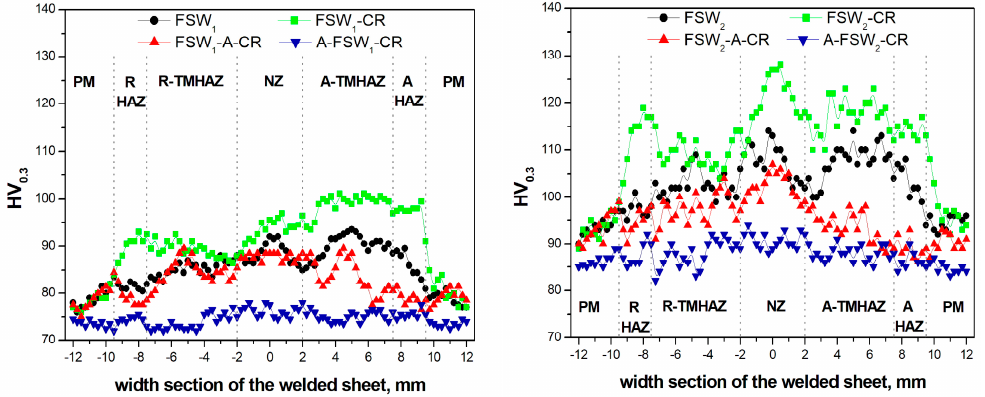
Figure 8. Microhardness profiles across the welded zone sections in the FSW, FSW-CR, and FSW-A-CR, A-FSW-CR, for ω = 600 rpm/ v = 200 mm/min (FSW 1 , left-hand side), and ω = 1800 rpm/ v = 75 mm/min (FSW 2 , right-hand side).